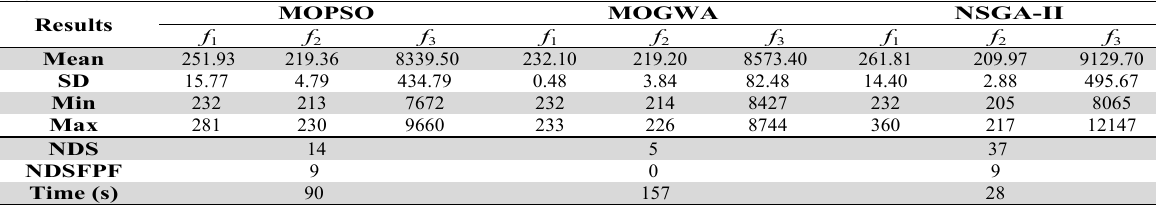
Algorithms result of the first